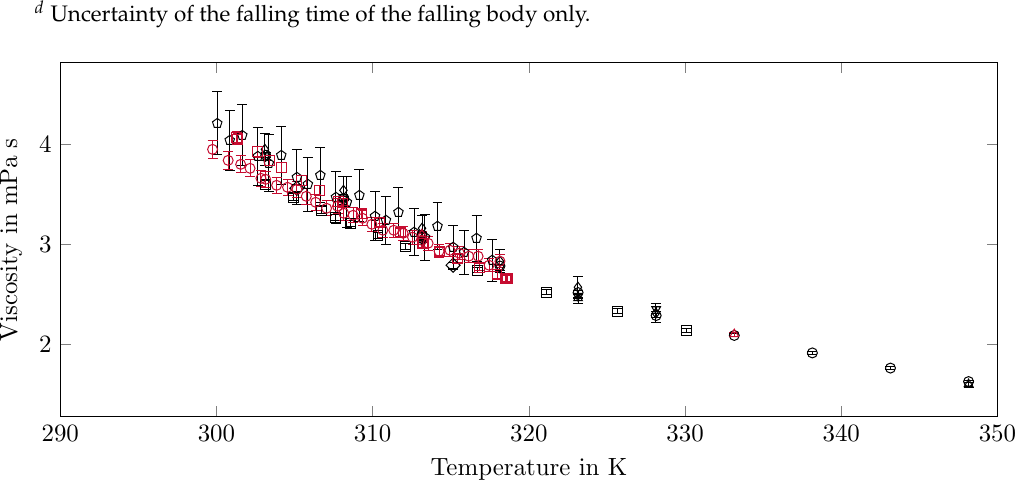
Figure 5. Summary of viscosity data from the literature. The error bars are the specified uncertainty of the data. The displayed data of Delgado et al. [98] are reduced to every fifth point of the available results. ◦ [6] (cid:3) [28] (cid:5) [63] ∆ [70] (cid:79) [84] ♦ [85]